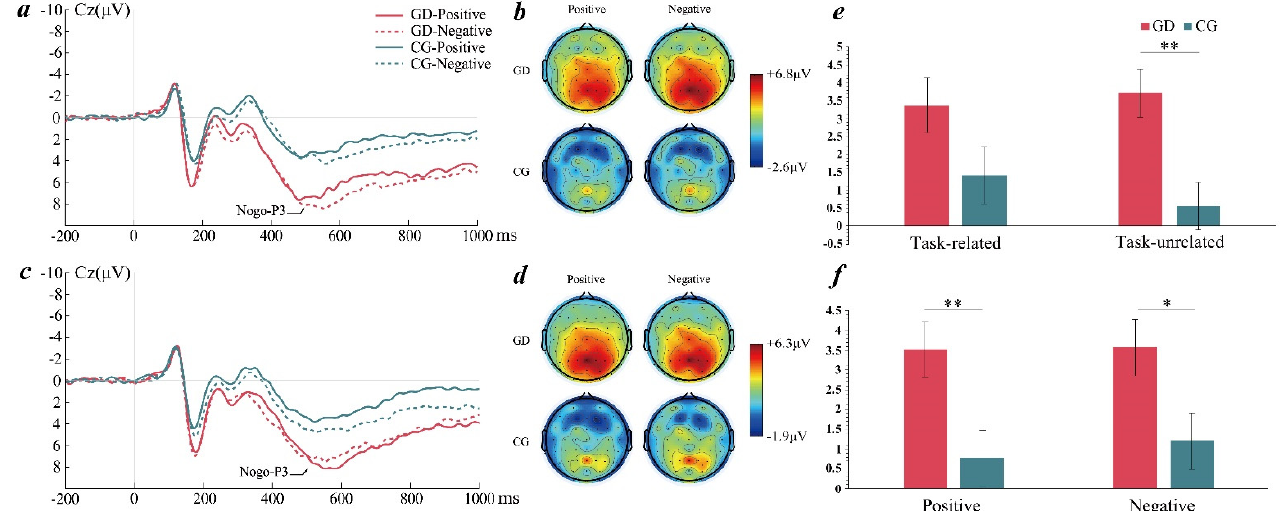
Figure 5. ( a ) Averaged ERPs at Cz for two groups in the task-unrelated condition; ( b ) topographic maps of nogo-P3 for two groups in the task-unrelated condition; ( c ) averaged ERPs at Cz for two groups in the task-related condition; ( d ) topographic maps of nogo-P3 for two groups in the task- related condition. GD = gaming disorder group, CG = control group. ( e ) Task × group interaction on nogo-P3 amplitudes. ( f ) Valence × group interaction on nogo-P3 amplitudes. The error bars stand for the standard deviation of the means. * p < 0.05, ** p < 0.01.